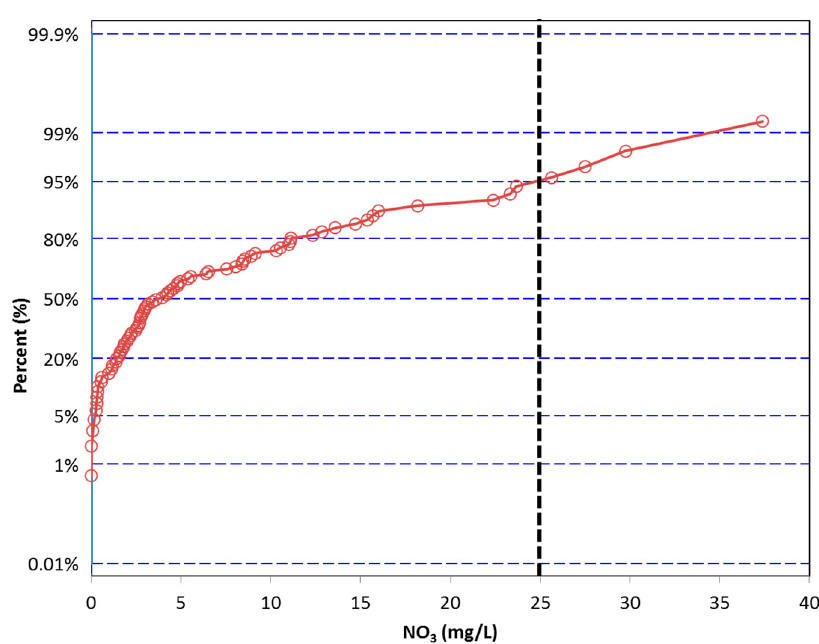
Figure 9. Cumulative frequency plot depicting the distribution of NO 3 content in spring discharges. Vertical line corresponds to the 25 mg NO 3 /L maximum recommended value in the Portuguese water quality standards for groundwater (Decree-Law n ◦ 236/98; 50 mg NO 3 /L is the maximum admissible value).